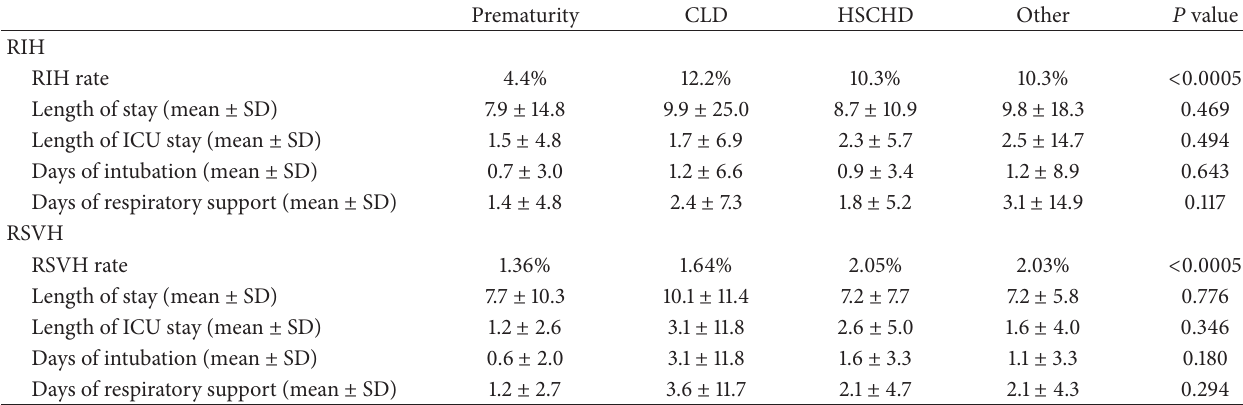
Table 4: Respiratory illness (RIH) and RSV-related hospitalization (RSVH) rates and morbidities encountered during hospital stay according to